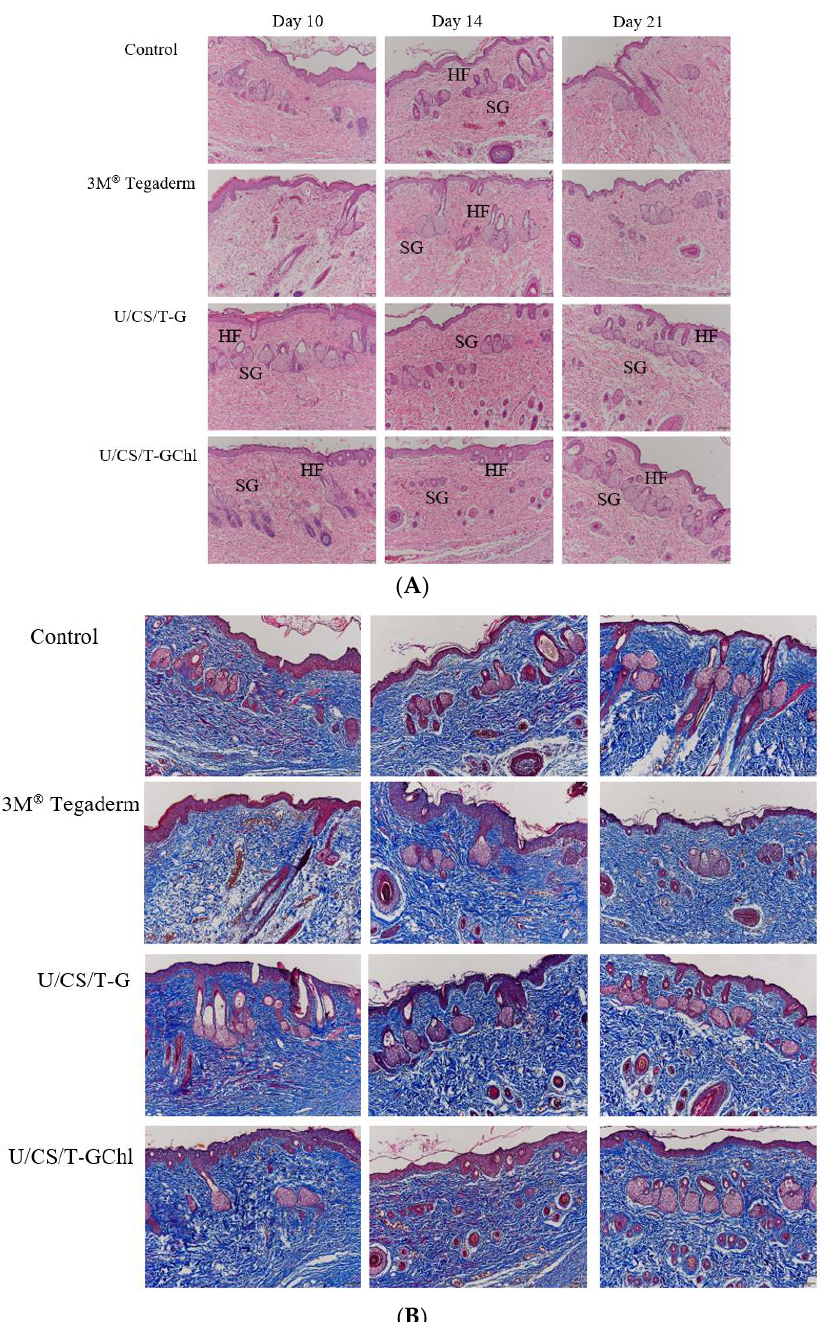
Figure 10. ( A ) Histological examination of skin wounds by H&E staining on day 10, 14, and 21 in SD rats. SGs: Sweat glands, HFs: hair follicles. The control group is the open wound without any dressing. (100×) ( B ) Histological examination of collagen in skin wounds by Masson’s trichrome (MT) staining on day 10, 14, and 21 in SD rats. The control group is the open wound without any dressing. (100×).